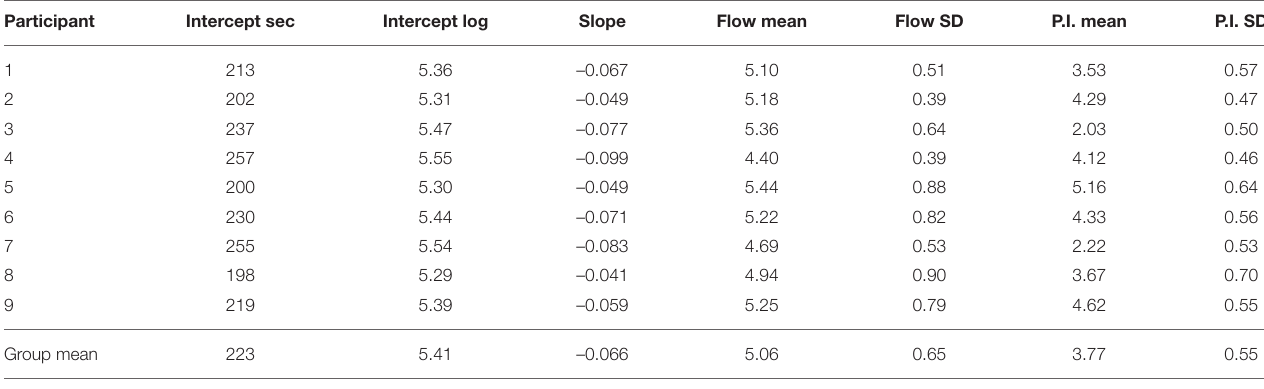
TABLE 2 | Individual learning rate parameters (cols 2–4), Flow (cols 5–6) and perceived importance (P.I., cols 7–8) scores. Last row shows group-mean values of each column. Participant